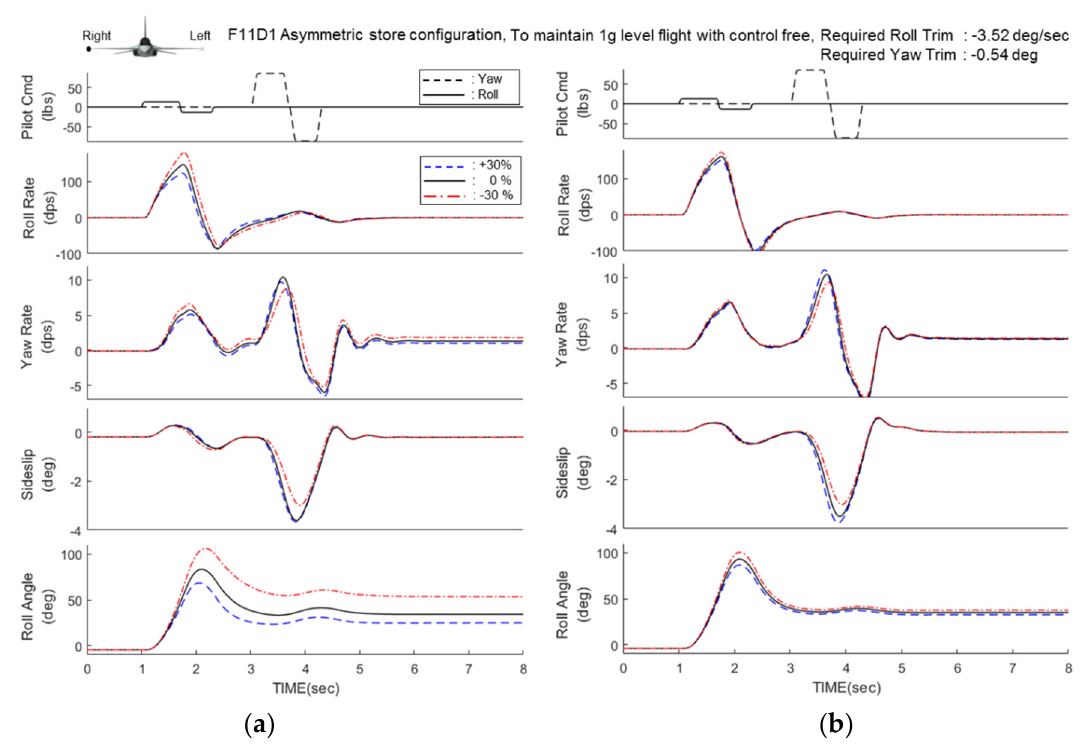
Figure 9. Robustness analysis results of the control system on L (cid:48) p aerodynamic coefficient uncertainties ( ± 30%) in M0.8, 20 Kft altitude ( a ) K aug = 0.0, ( b ) K aug = 0.8.